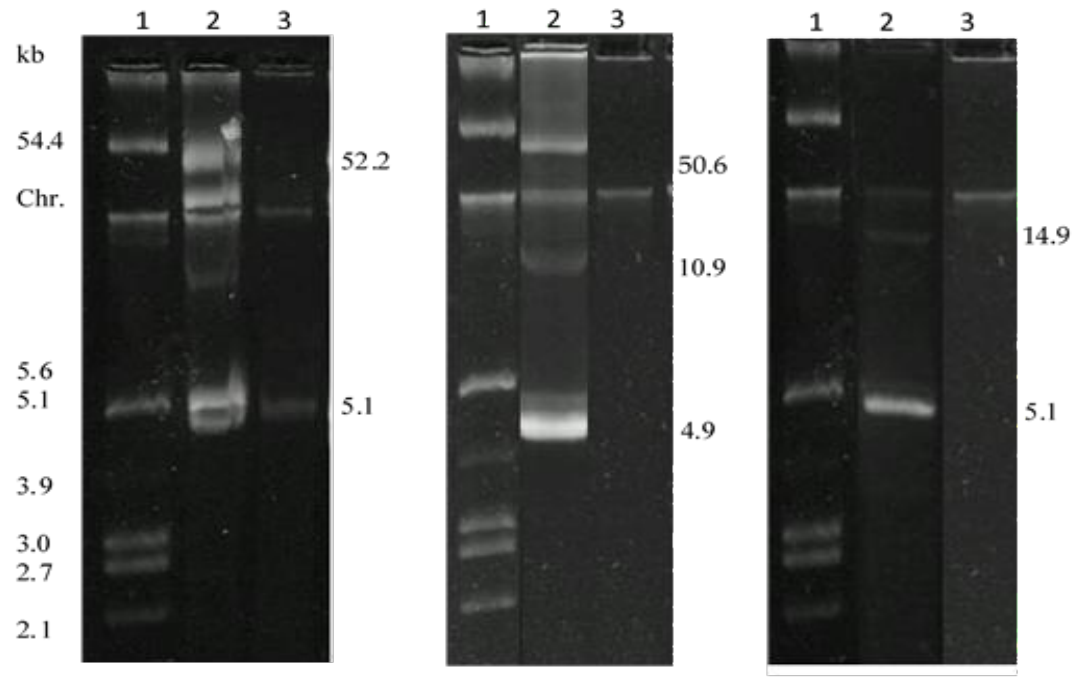
Figure 2. Plasmid profiles of E. faecium E23, B. thermophilum B23, L. bulgaricus L21 and respective Bac-derivatives after curing with ethidium bromide. Chr. denotes the position of chromosomal DNA. Lane 1: molecular size markers prepared from Escherichia coli ( E. coli) V517 (54.4, 5.6, 5.1, 3.9, 3.0, 2.7 and 2.1 kb); lanes 2: wild strains Bac+, lanes 3: variant strains Bac-.